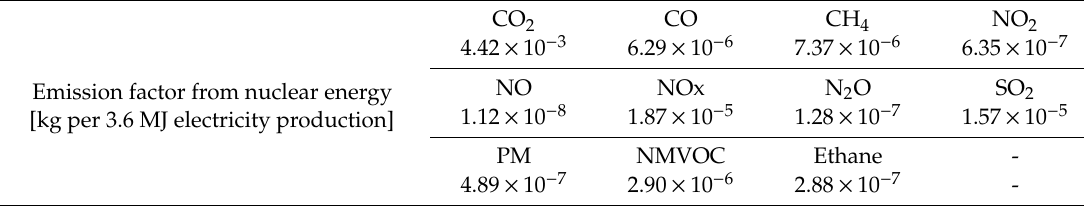
Table A6. Emission factors of nuclear energy at the Well-to-Tank phase.